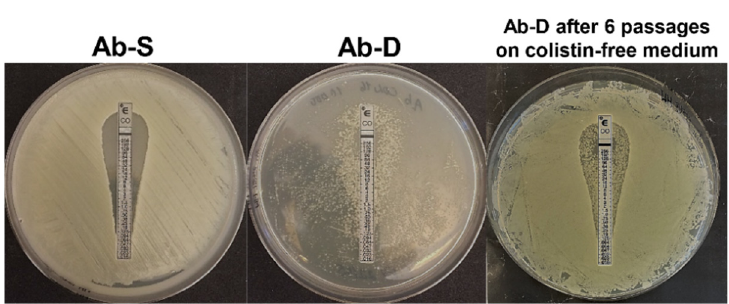
Figure 1. Diversity of the growth pattern of A. baumannii clinical isolate. Initially, this isolate was characterized as susceptible to colistin by Etest on MHA, S ≤ 2 µg/mL (Ab-S), on the left. A bacte- rial subpopulation displaying colistin-dependent growth was selected after 8-10 passages on agar containing 16 µg/mL colistin sulphate. This colistin-dependent population (Ab-D) grows only along the colistin Etest strip on a pear-like shape area between 0.125 and 256 µg/mL, ( middle panel ). When the Ab-D subpopulation was passed 6 times on agar base medium and further ap- plied for colistin Etest, a phenotypic heterogeneity within this bacterial population was observed (Ab-D after 6 passages on colistin-free medium). Most cells were growing in a colistin-susceptible manner and a certain amount retained a colistin-dependent growth pattern appearing along the colistin Etest strip ( right panel ).